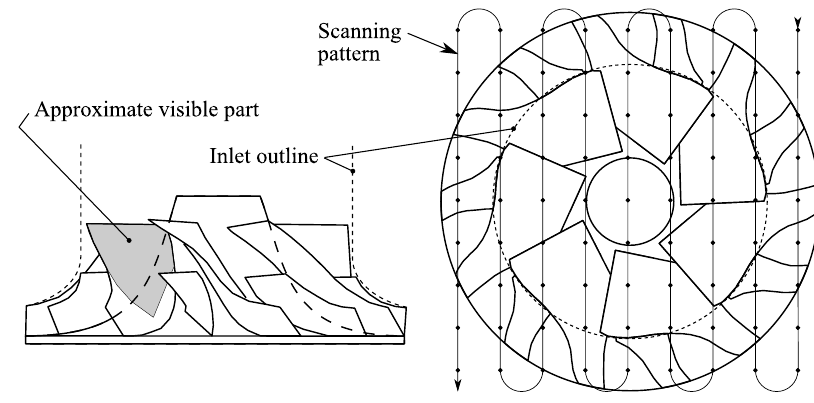
Figure 6. Overview of compressor wheel illustrating visible area and scanning pattern, with reduced number of points for visibility.